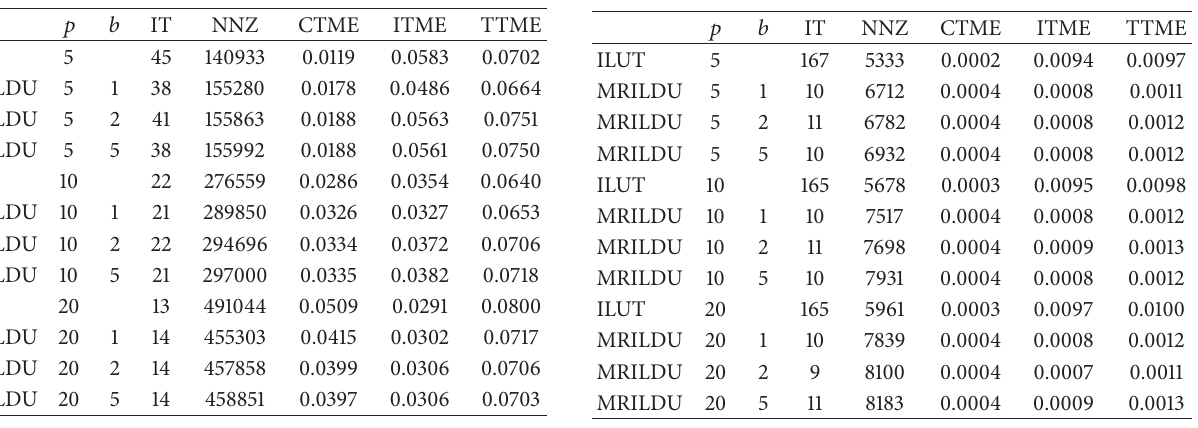
Table 9: Iteration results for matrix orsirr